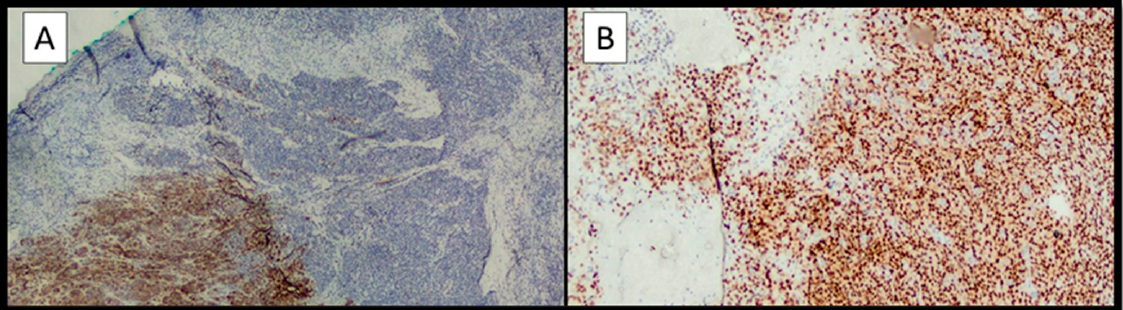
Figure 3. ( A ) Immunohistochemical preparation for Melan-A: note the positivity of Melan-A in the differentiated component (bottom left) and the negativity in the dedifferentiated part of the MM (top right and center) (immunohistochemistry for Melan-A, original magnification 4 × ). ( B ) Immunohistochemical staining for SOX-10: note the almost total positivity of the marker in all components of the MM (immunohistochemistry for SOX ‐ 10, original magnification 10×).